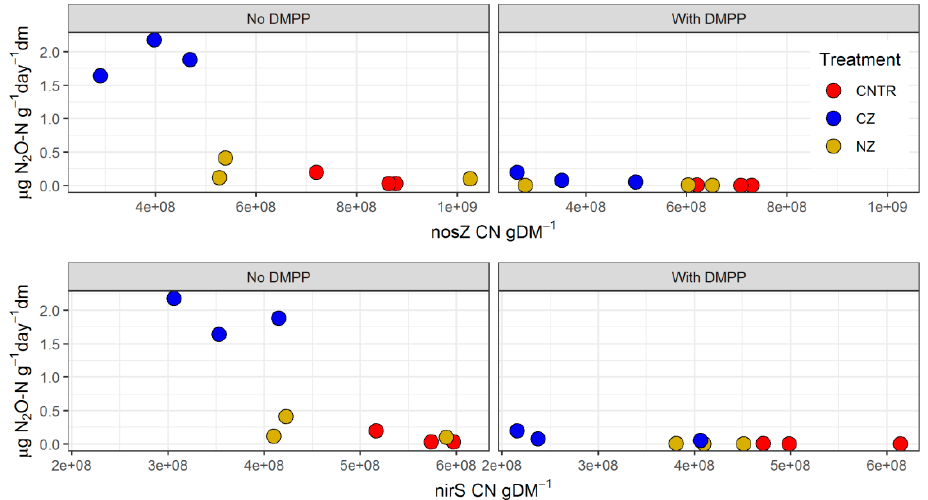
Figure 4. Relationship between nirS and nosZ functional genes and N 2 O emissions in treatments with and without DMPP addition. CNTR (red circles), NZ (dark-yellow circles), CZ (blue circles) like in Figure 1.